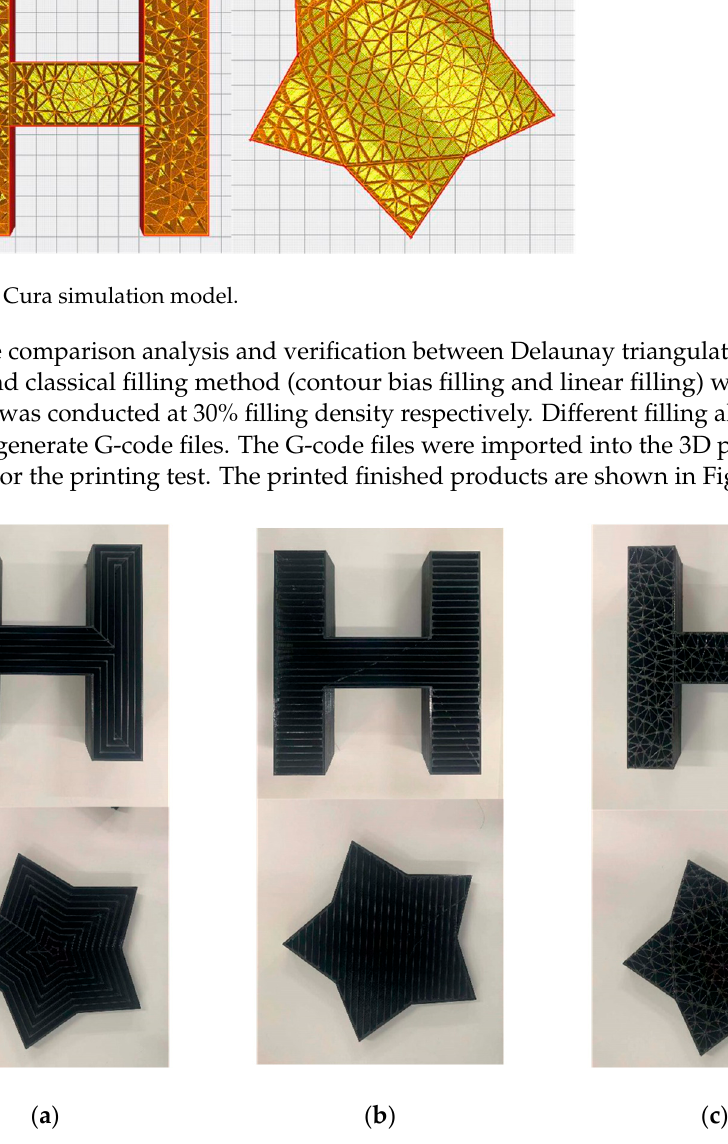
Figure 7. Printed physical objects. ( a ) Contour offset filling; ( b ) straight lines filling; ( c ) Delaunay triangulation filling.